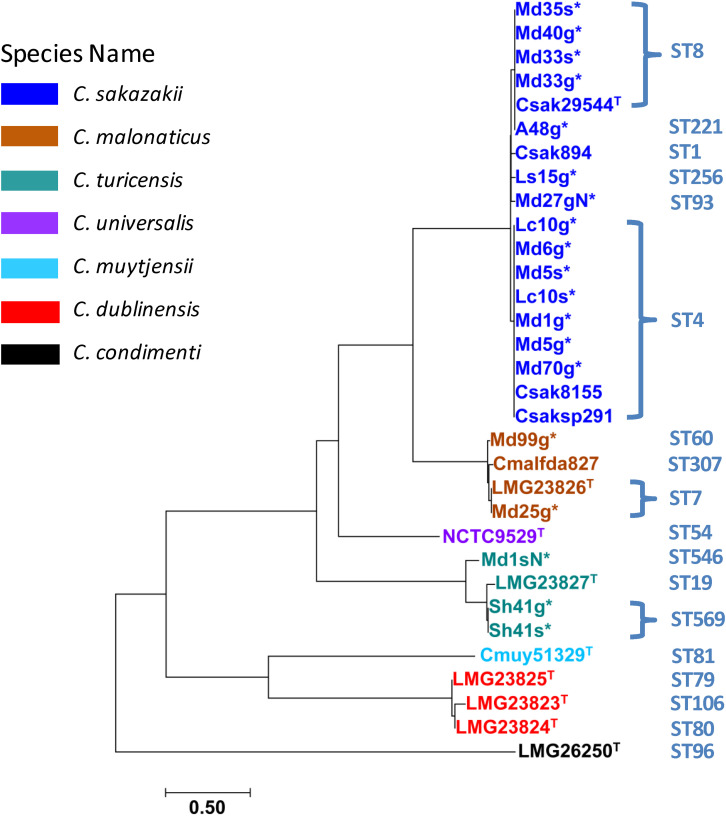
The phylogenetic analysis was inferred using the Neighbor-Joining method (Saitou and Nei, 1987). The optimal tree with the sum of branch length = 10.02357736 is shown. The tree is drawn to scale, with branch lengths in the same units as those of the evolutionary distances used to infer the phylogenetic tree. The evolutionary distances were computed using the Maximum Composite Likelihood method (Tamura et al., 2004) and are in the units of the number of base substitutions per site. The analysis involved 32 nucleotide sequences. All positions containing gaps and missing data were eliminated. There was a total of 308,989 positions in the final dataset. Evolutionary analyses were conducted in MEGA7 representing 2,000 core genes obtained from Spine analysis (Ozer et al., 2014; Kumar et al., 2016, 2018). The sequenced fly strains are labeled with an asterisk and the type strains are labeled with an upper caseT.